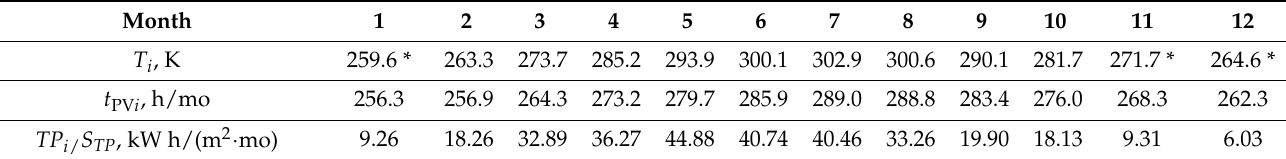
Table 8. Average monthly operation time of PV systems, t PV i , and operating temperature of PV cells, T i , and unit monthly technical potentials of solar energy for photovoltaic energetics, TP i / S TP